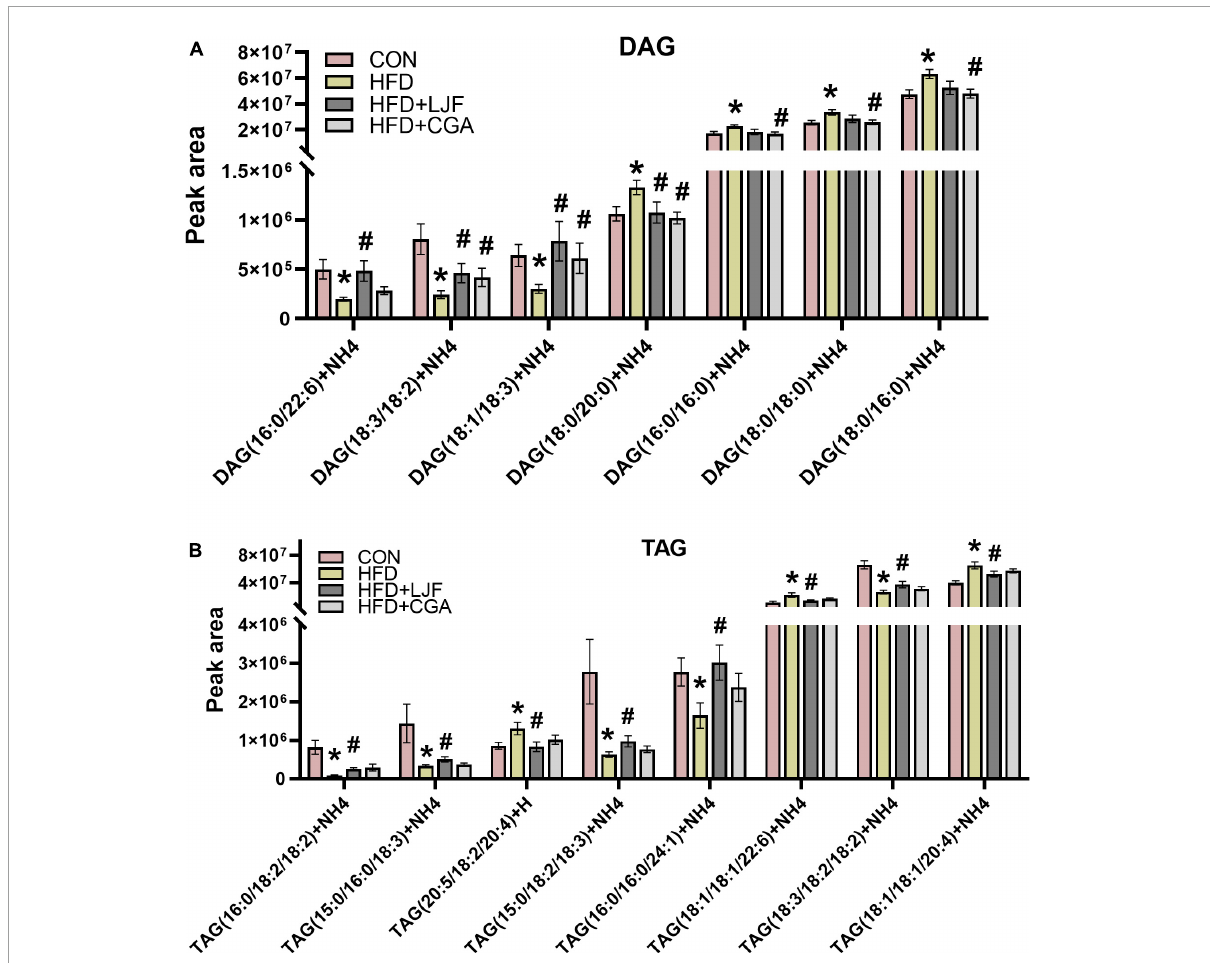
FIGURE6 Lonicerae Japonicae Flos and CGA regulated plasma diacylglycerol (DAG) and triacylglycerol (TAG) species levels. Lipidomic Analysis in Rat (A) plasma concentrations of DAG species. (B) Plasma concentrations of TAG species. Data are presented as bar graphs with means ± SEM ( n = 8 per group). * P < 0.05, vs. CON group; # P < 0.05, vs. HFD group; & P < 0.05, vs. HFD +